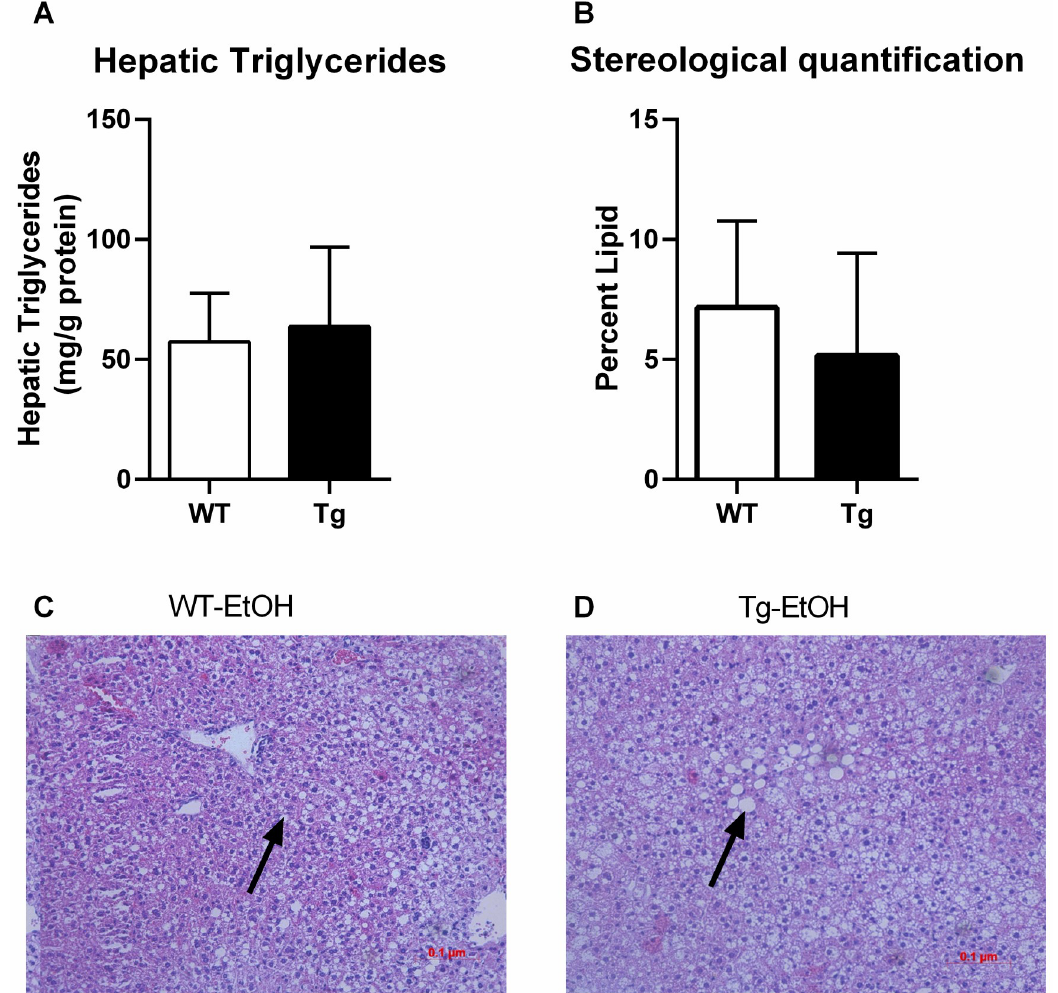
Fig 3. Hepatic lipid accumulation. Hepatic triglyceride levels were quantified and reported normalized to the total protein concentration (A). In addition, stereological analysis was performed on hematoxylin and eosin-stained images, 20x magnification (B). Representative hematoxylin and eosin-stained images from liver sections are also shown, the arrow indicates representative lipid droplet ( C-D ). Data are reported as means ± SD and significance was tested with an unpaired t-test; n = 10 and 5, WT and Tg respectively. Abbreviations: CTRP3, C1q tumor necrosis factor-related protein-3; Tg transgenic overexpression of CTRP3; WT,